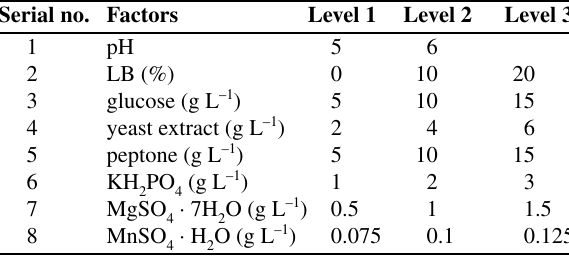
Table 1: Factors and their levels in the experimental design Serial no.